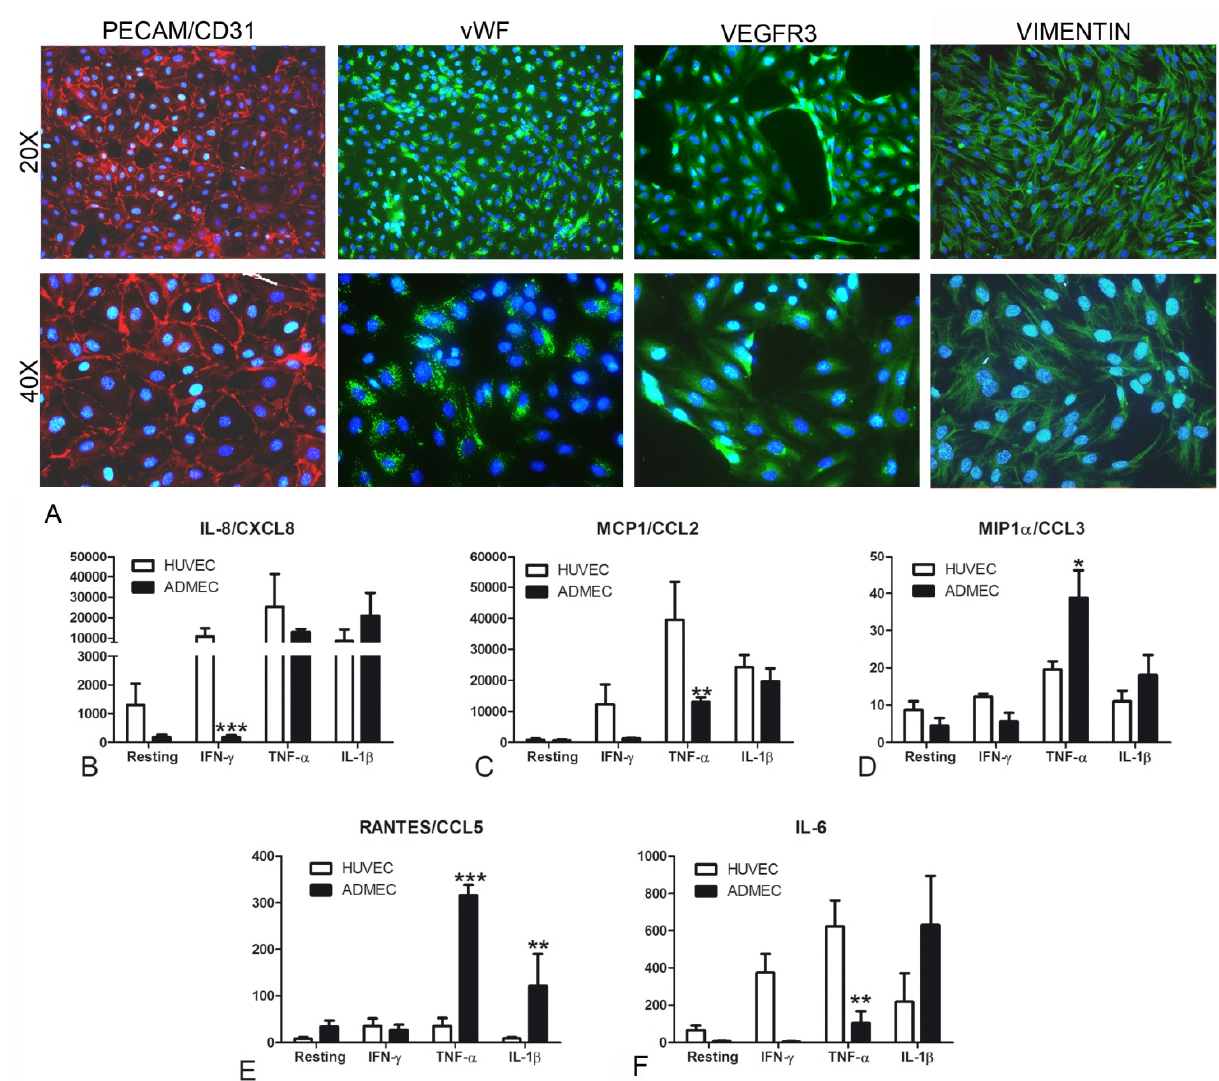
Figure 1. Phenotypic characterization of adult dermal microvascular endothelial cells (ADMECs). ( A ) Immunofluorescence (IF) analysis of PECAM/CD31 (in red), vWF, VEGFR3 and vimentin (in green) of isolated and cultured ADMECs. Scale bar 50 µ m. The production of IL-8/CXCL8 ( B ), MCP1/CCL2 ( C ), MIP1 α /CCL3 ( D ), RANTES/CCL5 ( E ) and IL-6 ( F ) was measured in the supernatant of HUVECs and ADMECs stimulated for 4 h with TNF- α using a bead-based multiplex immunoassay (Luminex ® ). The data represent the mean ± standard error (SE) of triplicate samples from five separate experiments * p < 0.05; ** p < 0.01; *** p < 0.005.